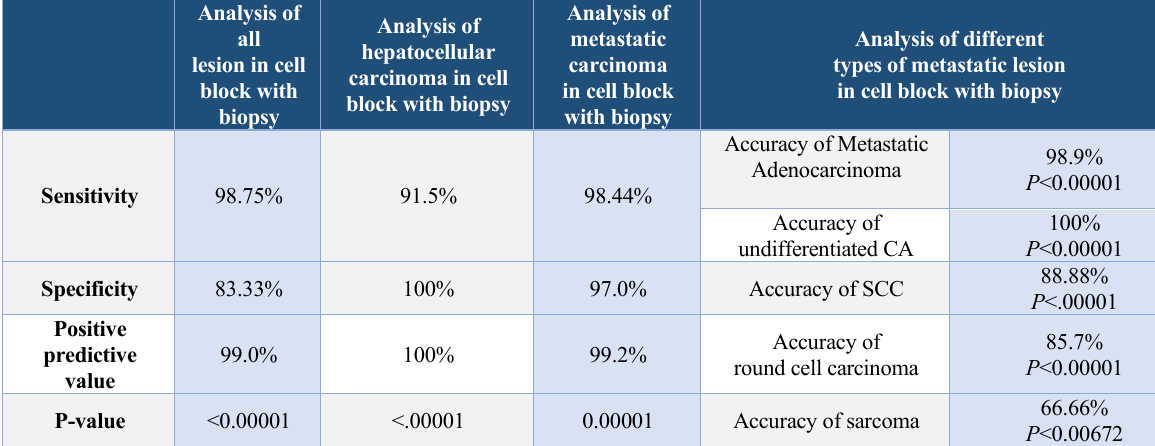
Table 5. Statistical analysis of the cell block and